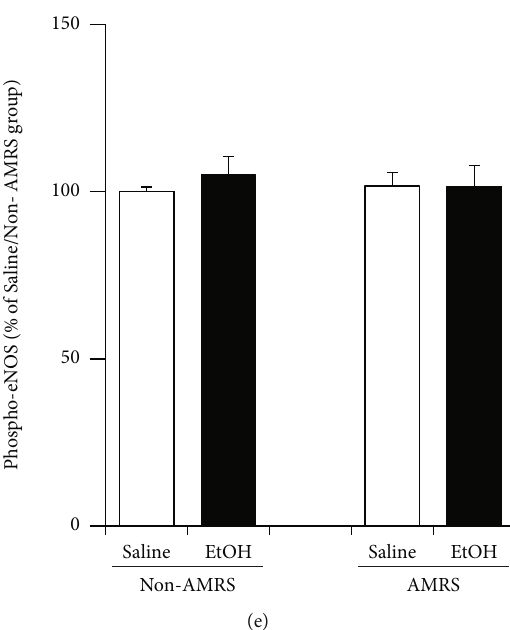
Figure 5: Solitary nNOS and eNOS protein expressions during EtOHW. Data are expressed as mean ± SEM ( n = 5 ) of the percentage of saline/non-AMRS group. ### p < 0 : 001 versus saline/non-AMRS group; $$$ p < 0 : 001 versus saline/AMRS group; @@@ p < 0 : 001 versus EtOH/AMRS group.